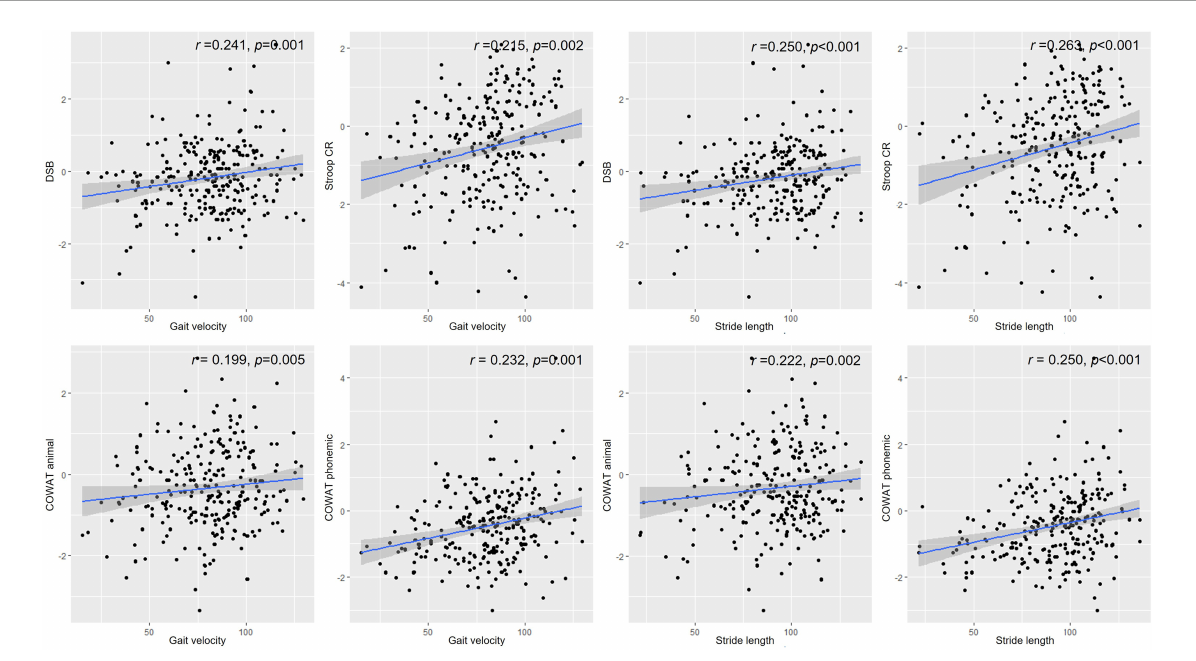
FIGURE1 Correlations between gait parameters and neuropsychological performance. Values depicted in the scatter plot represent gait velocity or stride length on the X-axis and score in the Digit Span Test backward, Stroop color reading, animal component of COWAT, or phonemic component of COWAT on the Y-axis. DSB, Digit Span Test backward; Stroop CR, Stroop color reading; COWAT animal, animal component of COWAT; COWAT phonemic, phonemic component of